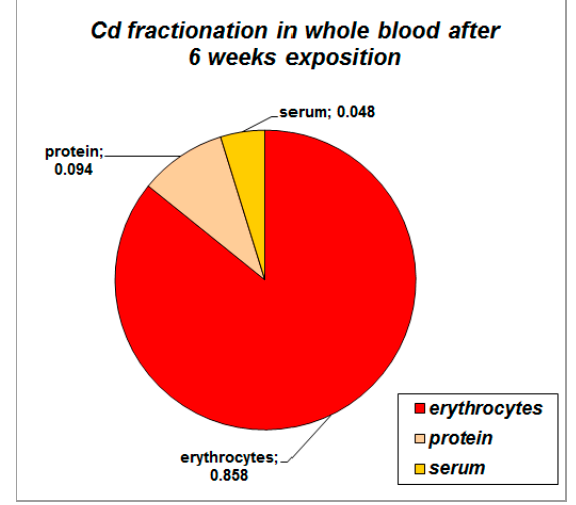
Figure 8. Cadmium content in individual blood fraction following six weeks exposure.